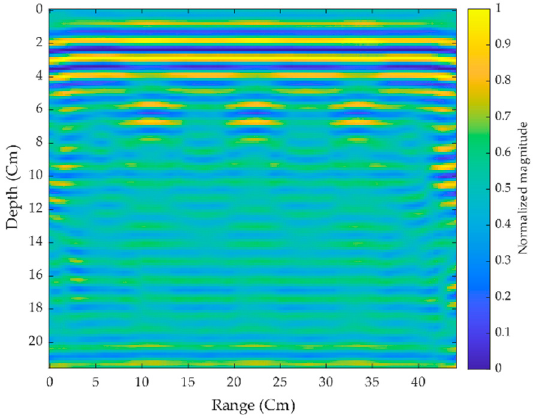
Figure 11. Scanned raw data from the radar module.